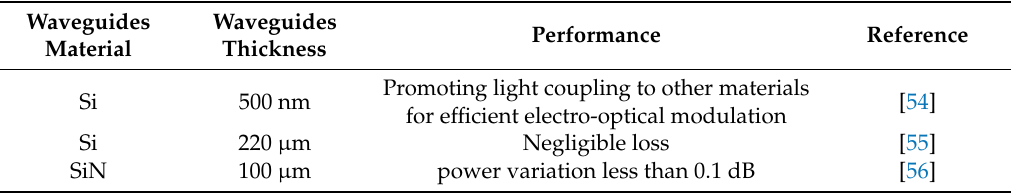
Table 3. Summary of 3D PICS structures.